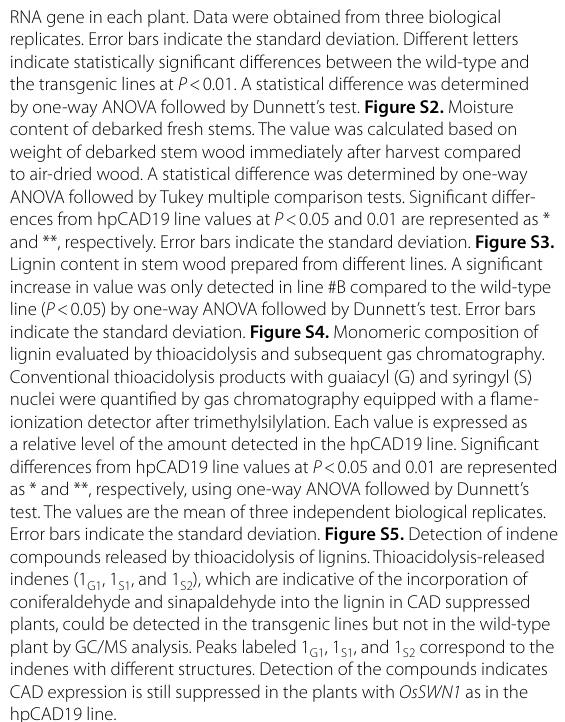
Fig. 6 Enzyme saccharification efficiency of wood powder prepared from the stems of each line. Significant differences from the enzyme saccharification efficiency of the hpCAD19 line at P < 0.05 and 0.01 are represented as * and **, respectively. A statistical difference was determined by one-way ANOVA followed by Dunnett’s test. The values are the mean of three independent biological replicates. Error bars indicate the standard